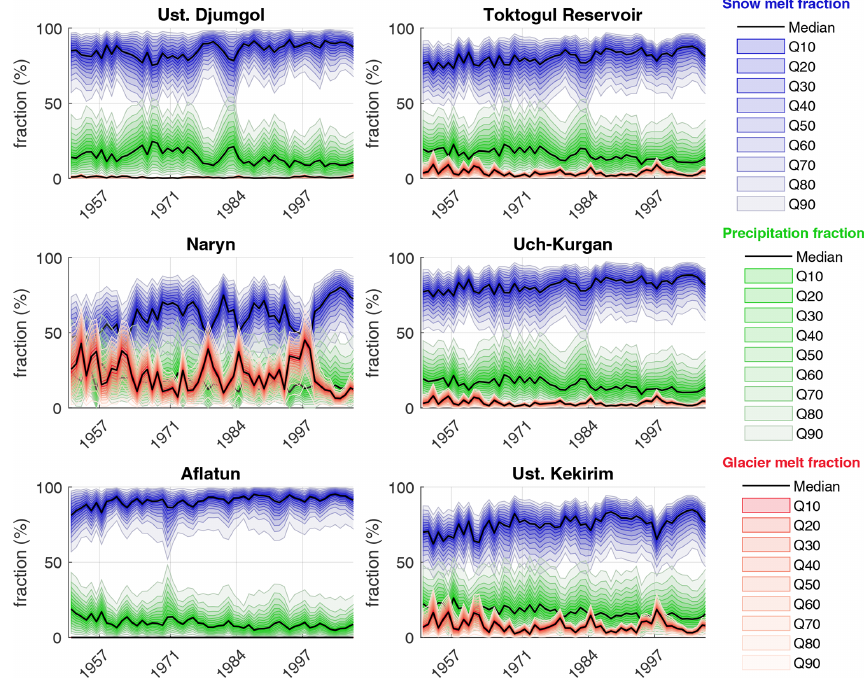
Figure 11. Annual percentage contribution of rain (green), snowmelt (blue) and glacier melt (red) to the total runoff for the period 1951–2007. The coloured envelopes show the 10%-interval increasing percentile limits and the 50th percentile lines are shown in black.